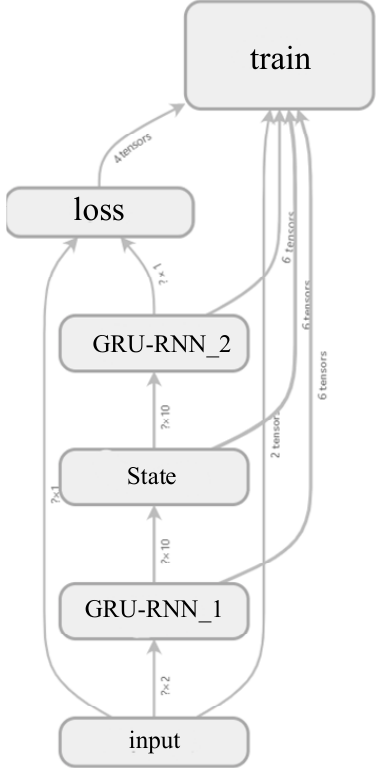
J. Mar. Sci. Eng. 2020 , 8 , x FOR PEER REVIEW Figure 18. Double GRU-RNN TensorFlow framework. Figure 18. Double GRU-RNN TensorFlow framework.